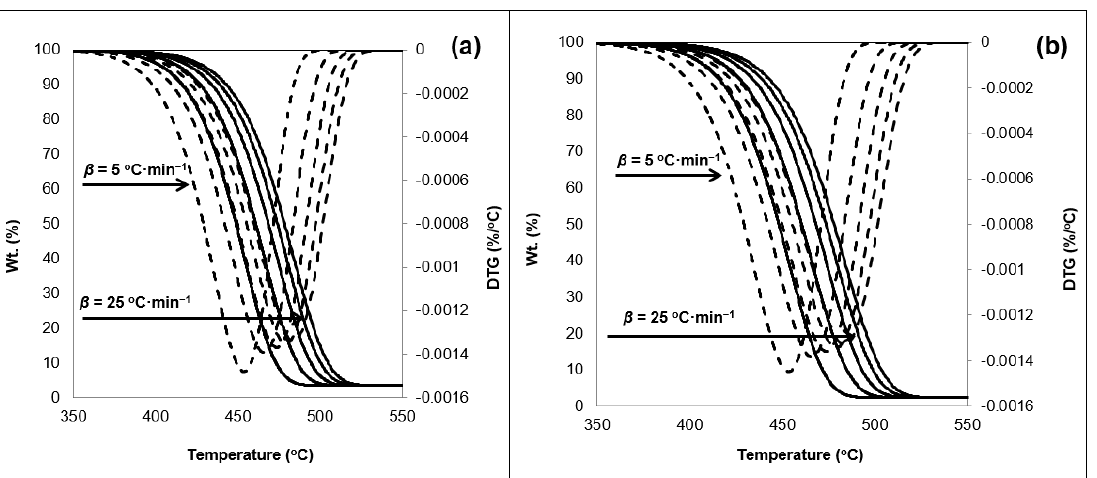
Figure 1. TGA thermogram showing weight loss (—) and first derivative (- - -) of the 50/50 sample ( a ) pre-exposure and ( b ) exposed to 11 days in N 2 atmosphere with respect to heating rates (5 to 25 °C·min − 1 ) in sequential order.